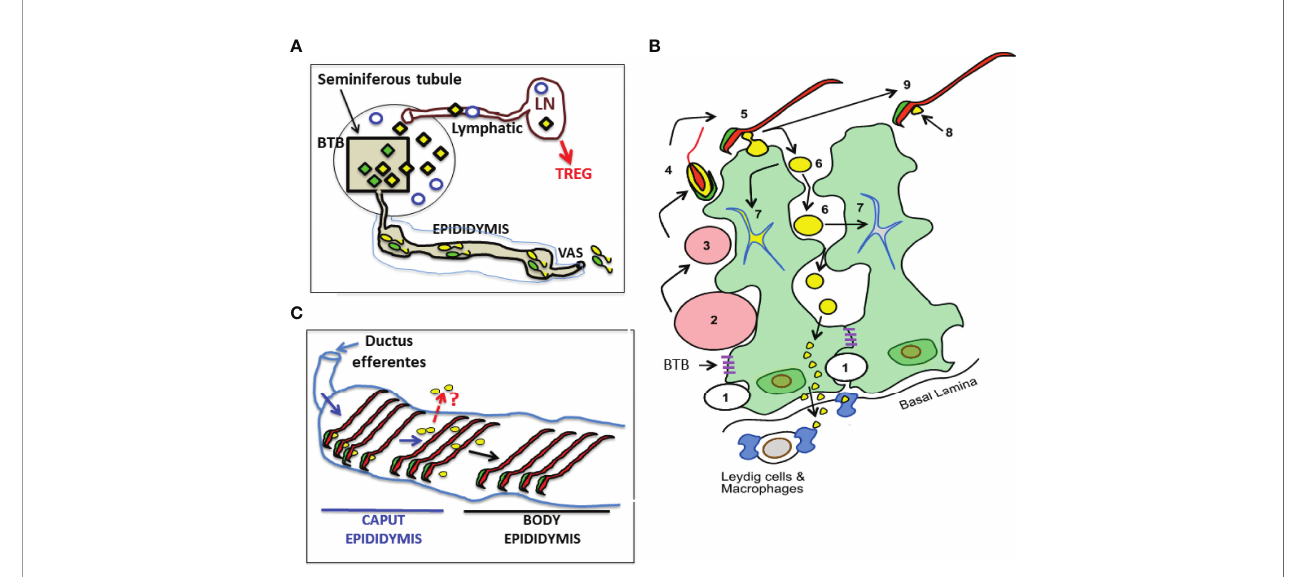
FIGURE 1 | A Landscape of Cellular Antigens in Testicular, Epididymal and Regiona Lymph Node (LN) Compartments. (A) The blood-testis barrier (BTB) divides normal testis into the seminiferous tubule and the interstitial compartment. The Ag of the interstitial space, located outside the BTB, including the Leydig cells (empty blue circles), spermatogonia, and preleptotene spermatocytes (not shown) are likely to be exposed. Seminiferous tubule contains all the unique Ag in meiotic germ cells (diamonds). Unexpectedly, some meiotic germ cell antigens (yellow diamonds) continuously egress into interstitial space and reach the regional LN via the afferent lymphatic, while other antigens are sequestered (green diamonds). (B) A cartoon showing the location and fate of male germ cell development adjacent to two Sertoli cells (with green cytoplasm). Spermatogonia ( 1 ) traverse the BTB to become spermatocytes ( 2 and 3 ), and early spermatids ( 4 ) that develops acrosome (in green), cytoplasm (in yellow), nucleus and tail (in red). Spermiation occurs when late spermatid ( 5 ) becomes sperm ( 9 ). Some meiotic germ cell cytoplasm becomes the residual body (RB) ( 6 ) while others become the cytoplasmic droplet (CD) that attaches to the sperm ( 8 ). Most RB are engulfed and destroyed by Sertoli cell ( 7 ). However, some RB stay outside the Sertoli cells until reaching their base, and enter the interstitial space. Systemic Treg-dependent tolerance mechanism protects the meiotic cell antigens in RB and CD (example: LDH3). The sequestered meiotic germ cell antigens (example: ZAN in sperm acrosome) are not protected by systemic tolerance in normal mice. (C) The CDs (yellow spheres), initially attached to the sperm in the caput epididymis, soon disappear and are undetectable in the body epididymis. A question (in red): Do the exit of CD Ag in epididymis represent an additional pathway of sperm Ag